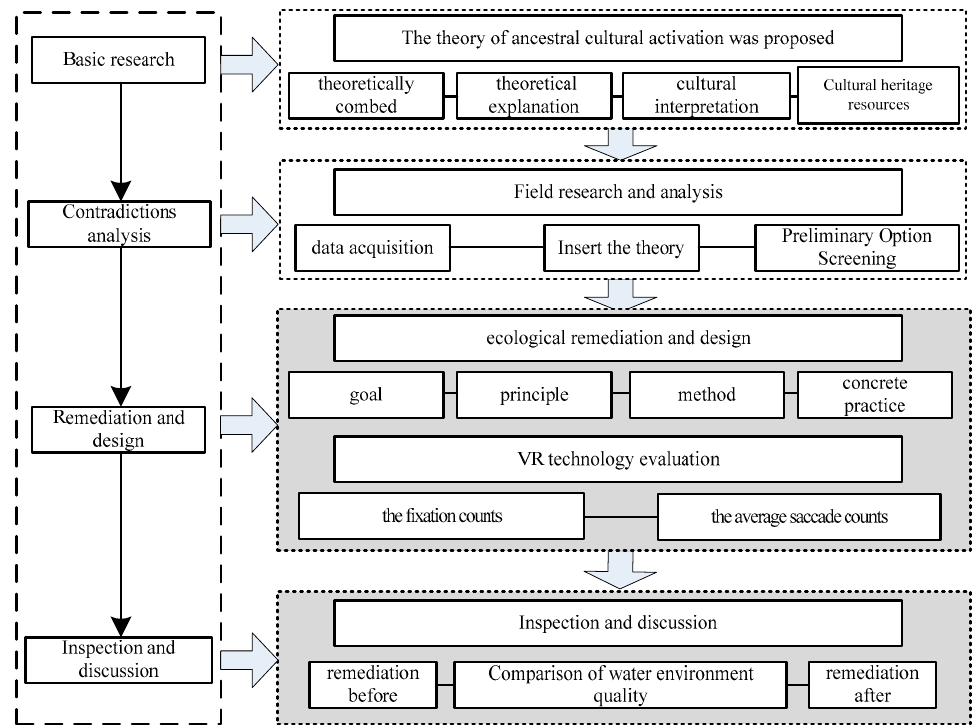
Figure 2. Evaluation methods and steps of VR technology